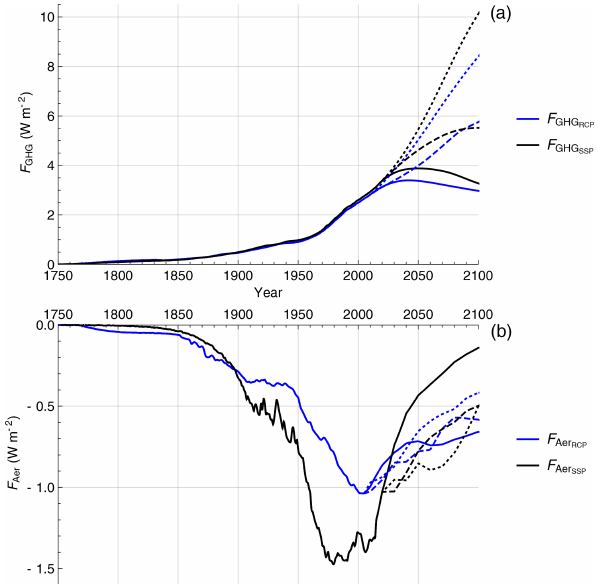
Figure 1. (a) The anthropogenic forcing series, the sum of the greenhouse gas forcing F GHG and respective aerosol forcing se- ries F Aer (black) or F Aer (blue) are shown over the histor- RCP SSP ical period and projection period until 2100 for RCP2.6/SSP1-26 (solid), RCP4.5/SSP2-45 (dashed) and RCP8.5/SSP5-85 (dotted). (b) The anthropogenic aerosol forcing series used, F Aer (blue) RCP and F Aer (black), following the same scheme as above. Updated SSP from Hébert et al.